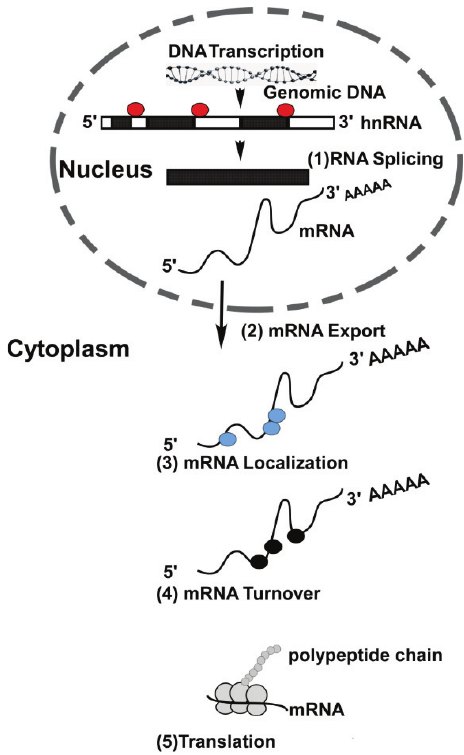
Figure 1. RNA-binding proteins and their role in RNA metabolism: Genomic DNA is transcribed in the nucleus resulting in generation of hnRNA. RNA-binding proteins (RBP) are involved in ( 1 ) splicing and alternative splicing of hnRNA, resulting in the formation of mRNAs. Messenger RNAs are then transported from nucleus into the cytoplasm ( 2 ). In the cytoplasm, RBPs aid in the localization of mRNAs to their final destination site ( 3 ). Once in the cytoplasm, each mRNA has a specific turn-over rate ( 4 ) that can be modulated by association with selective RBPs. The turn-over rate of mRNAs in cells can be altered in response to intrinsic and extrinsic stimuli. Messenger RNAs serve as a template for translation and RBPs play an important role in translation ( 5 ).